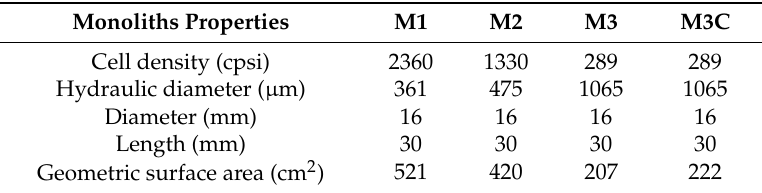
Table 5. Properties of the FeCrAlloy ®